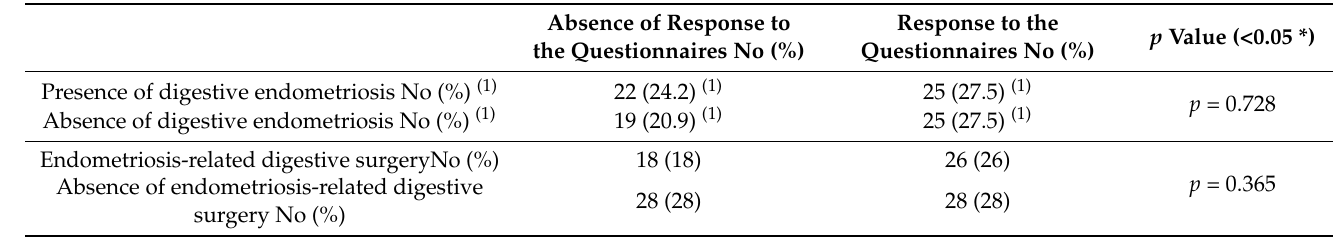
(1) (valid percentage) 9 missing